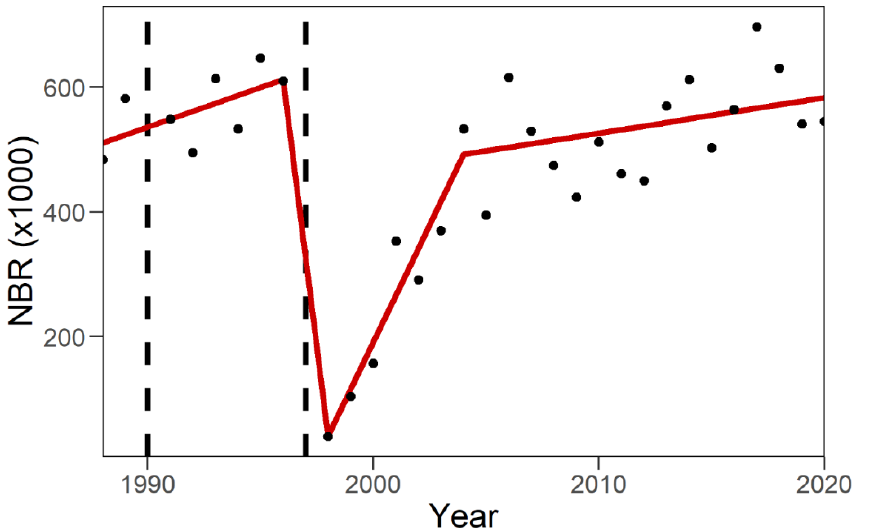
Figure A1. Example pixel that experienced a fire in December 1996. Black dots are medoid surface reflectance values, and the red line is the LandTrendr fitted model as in Figure 4. Vertical dashed black lines indicate years with no available imagery. The postNBR year 1997 is missing, so LandTrendr fits a two-year decline to 1998. In this example, preNBR is 1996 and postNBR is now 1998.